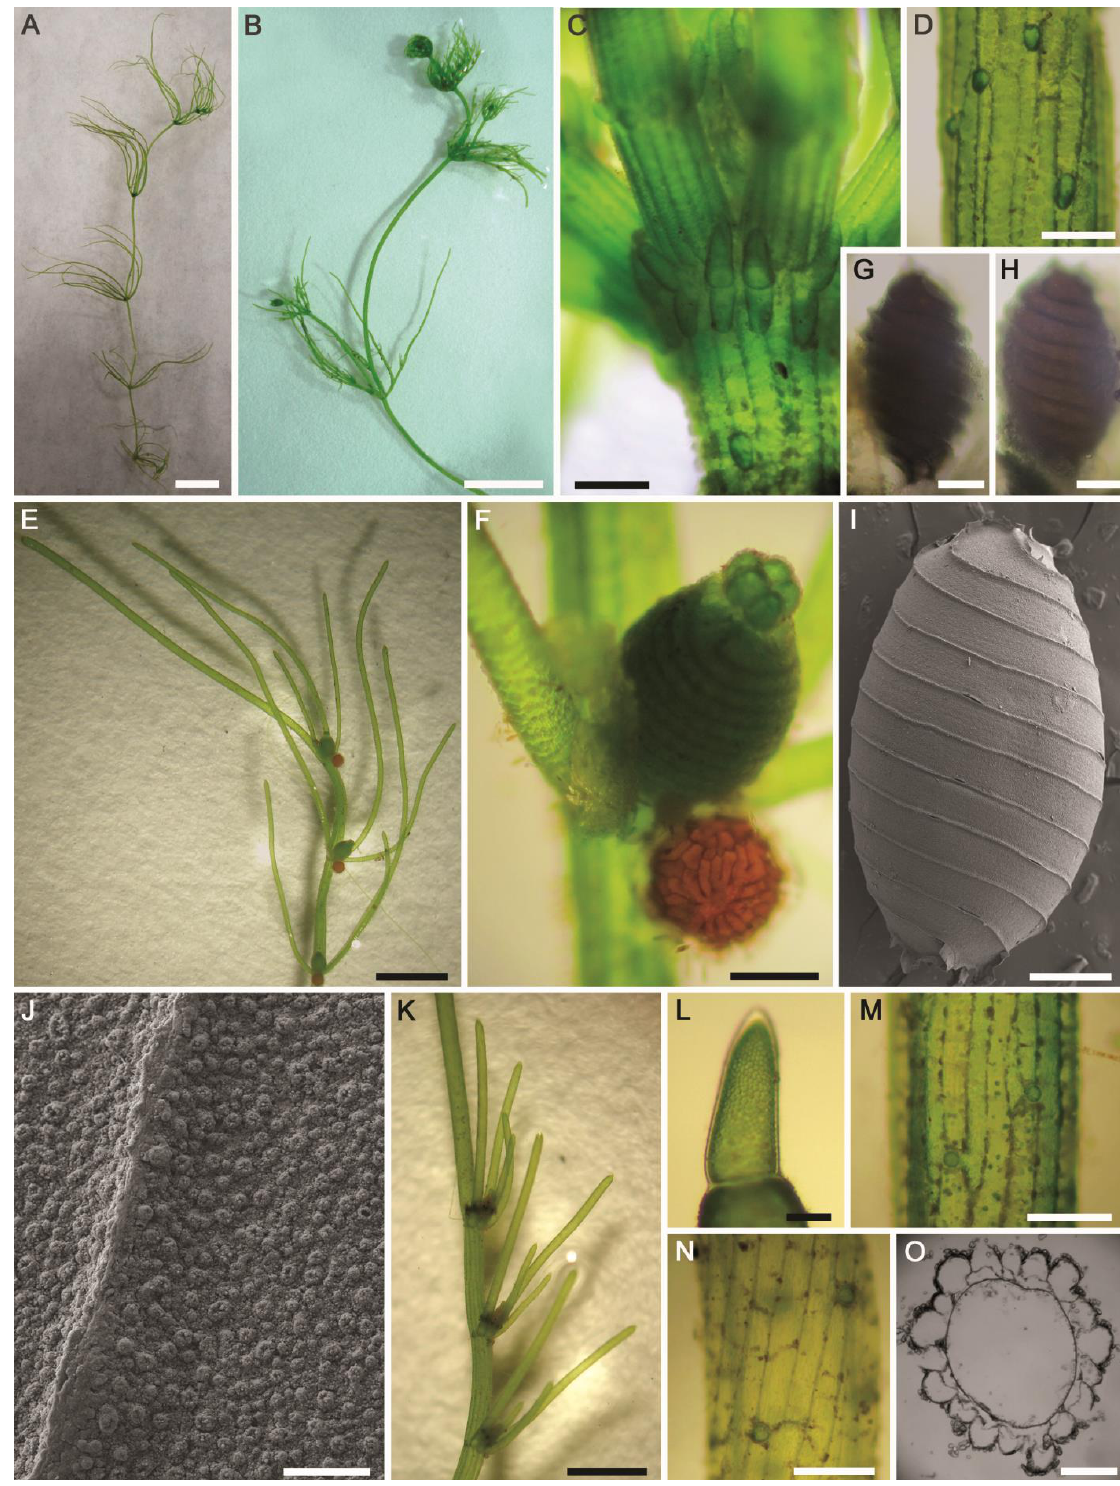
Figure 11. Morphotaxonomic features of Chara vulgaris found in the Siwa ( A – J ) and El-Farafra ( K – O ) Oases (the Western Desert of Egypt): ( A , B ) macroscopic habitus; (C) axial node showing stipulodes; ( D ) diplostichous aulacanthous cortex; ( E ) branchlet; ( F ) conjoined gametangia; ( G – I ) oospores; ( J ) SEM of oospore showing granulate ornamentation with pores on fossae and ridges; ( K ) branchlet; ( L ) terminal branchlet cell; ( M , N ) diplo- to slightly irregularly triplostichous cortex; ( O ) internode cross-section cross. Scale bars: ( A , B ) = 1 cm; ( E , K ) = 2 mm; ( C , D , F , M , N ) = 200 μ m; ( G , H , I ) = 100 μ m; ( L , O ) = 50 μ m; ( J ) = 5 μ m.